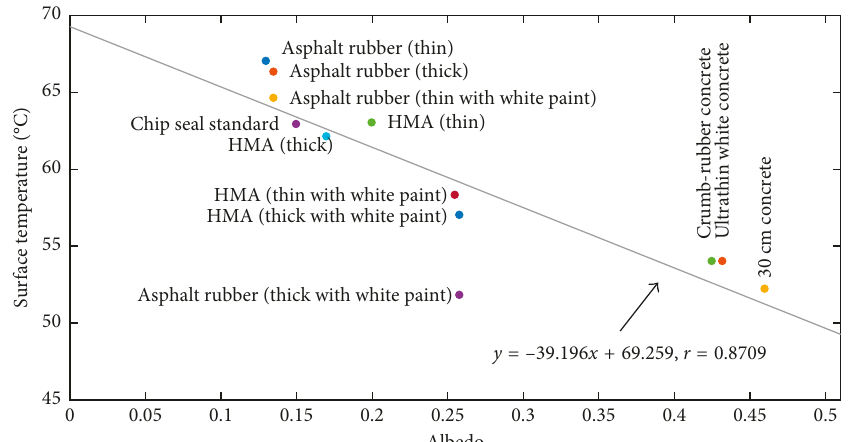
Figure 5: Albedo and surface temperature for different types of pavements (based on [10,